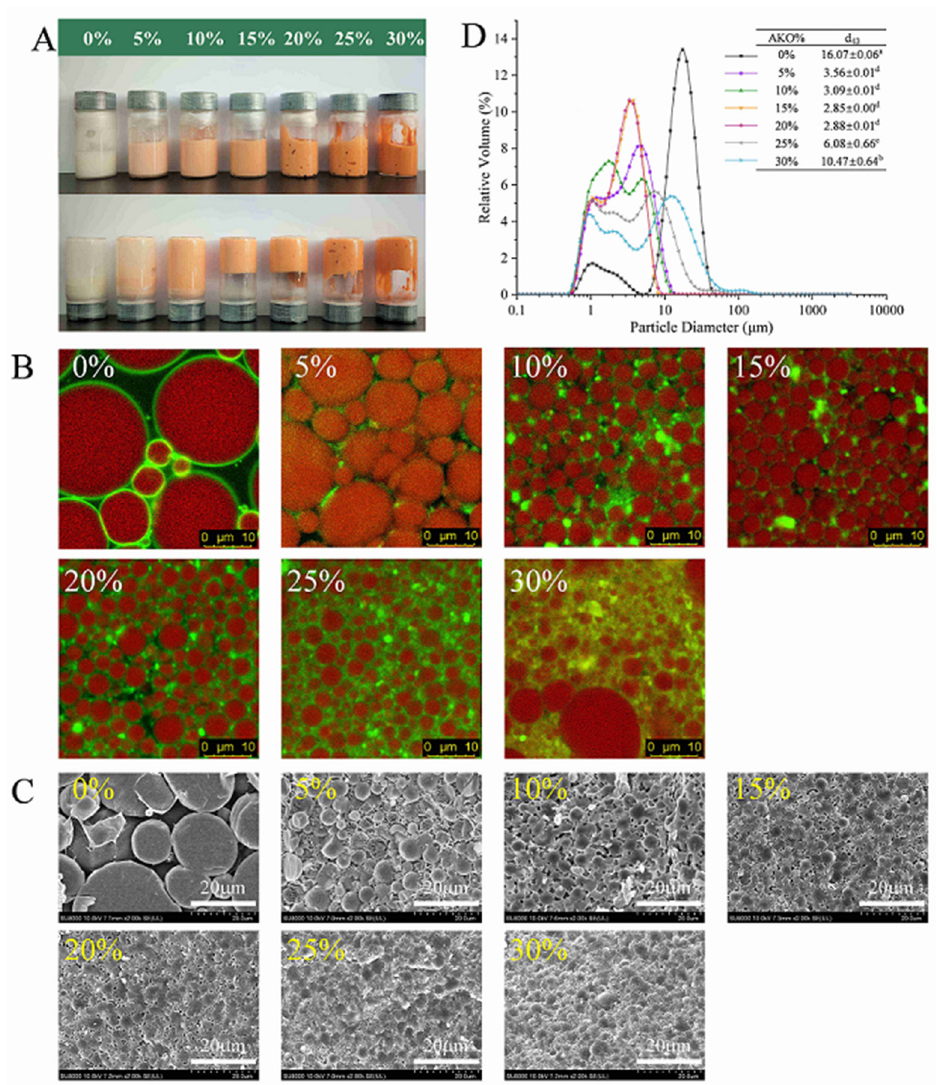
Figure 2. Appearance ( A ), CLSM observation (Scales bars, 10 µ m) ( B ), cryo-SEM observation (Scales bars, 20 µ m) ( C ), and particle size distributions ( D ) of HIPEs with different levels of Antarctic krill oil (AKO) (0, 5, 10, 15, 20, 25, and 30%, w/w ). In the CLSM micrographs, oil droplets were stained with Nile red and shown in red at 488 nm, and casein particles were stained with Nile blue A and shown in green at 633 nm. Scale bars, 10 µ m. Values with different letters (a–d) are significantly different ( p < 0.05). CLSM was employed to elucidate the microstructure of the HIPEs. As shown